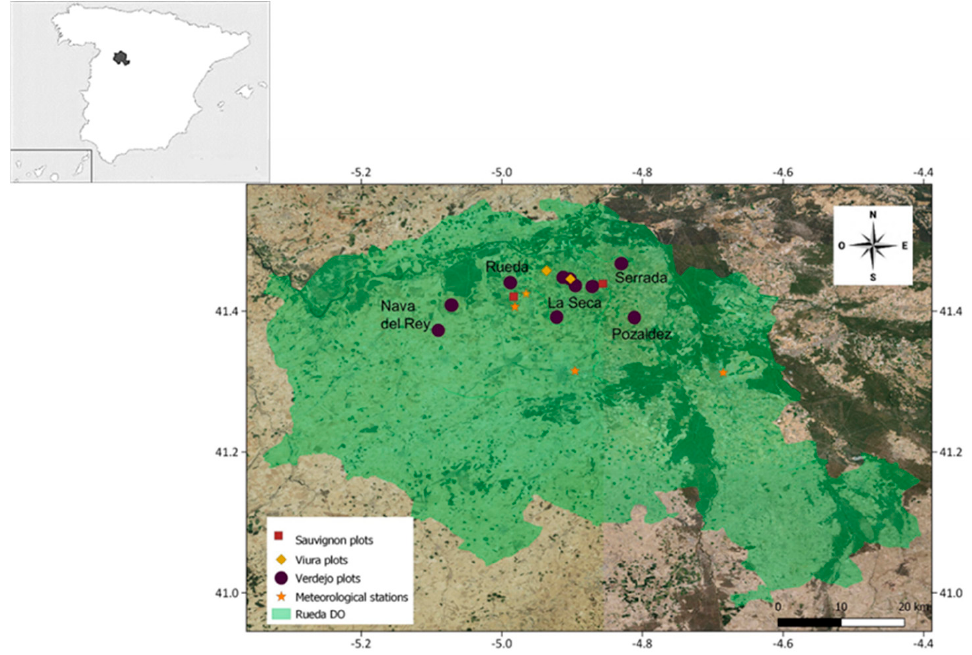
Figure 1. Location of the study area, analysed plots and meteorological stations. The soils have organic carbon contents that varied between 6.4 and 2.18 g kg − 1 , clay contents that range between 130 and 200 g kg − 1 , silt contents between 170 and 279 g kg − 1 and sand contents between 547 and 673 g kg − 1 , whereas the coarse fraction (>2 mm) varied between 85 and 202 g kg − 1 . The soil pH ranges between 7.9 and 8.3 (information obtained from the European Soil database (ESDAC) and the Soil Data base from